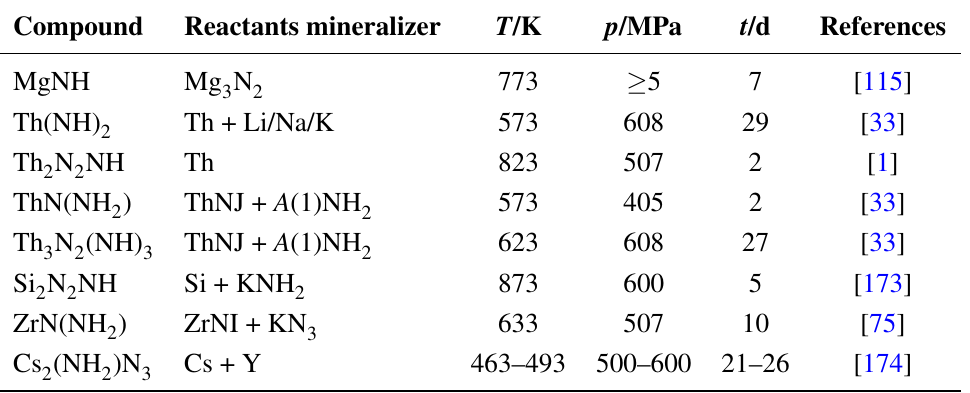
Table 8. Conditions for the ammonothermal synthesis of micro crystalline binary imides, nitride imides and amide